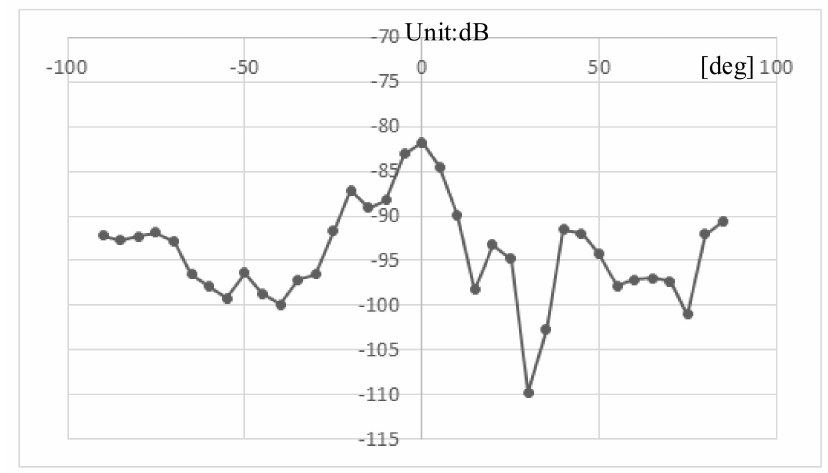
Figure 24. BE horn receiving power change with